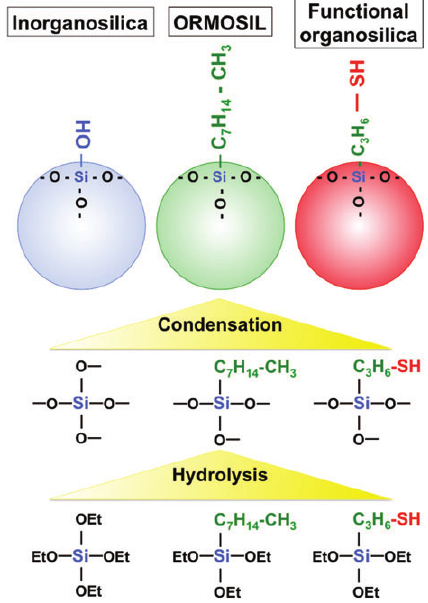
Figure 1 Schematic structure of three types of silica nanoparticles and syntheses from their sources.